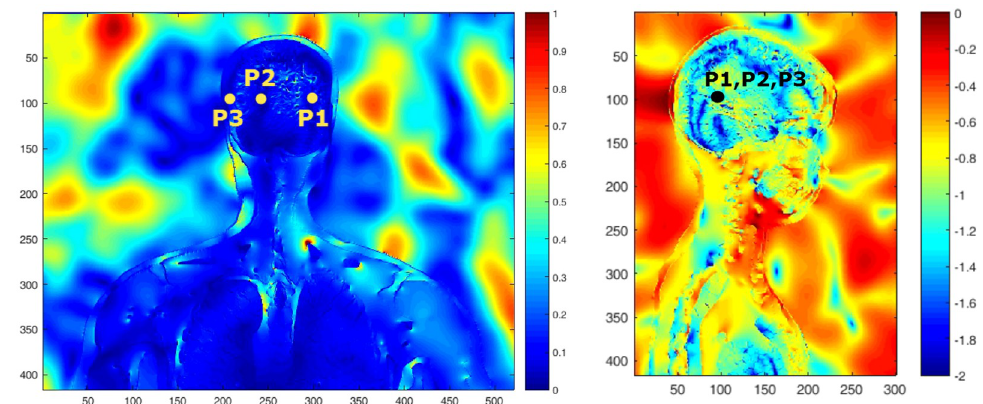
Fig 8. Two snapshots of the time-domain animations of the amplitude of the E-field normalized to the incident value: Frontal view with linear color scale (left), and side view with logarithm scale (right). The location of the 3 points for which the transfer function is calculated in Fig 9 are shown in black.